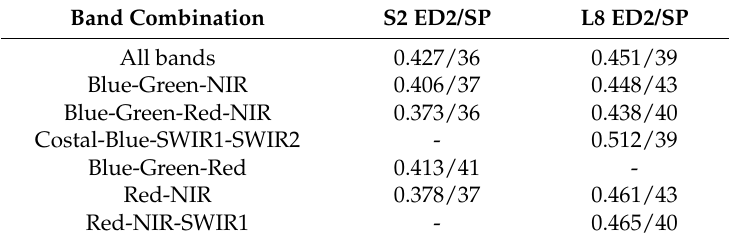
Table 1. Modified ED2 and its associated scale parameter (SP) (shape and compactness were fixed to 0.5) for the tested Sentinel-2 (S2) and Landsat 8 (L8) equal-weighted band combinations. In grey, the best common results achieved.